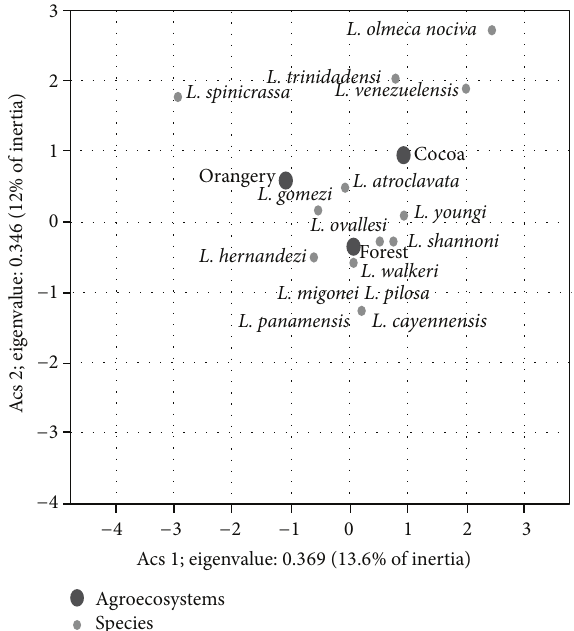
Figure4:Associationbetweensandfliesspeciesandagroecosystems by the simple correspondence